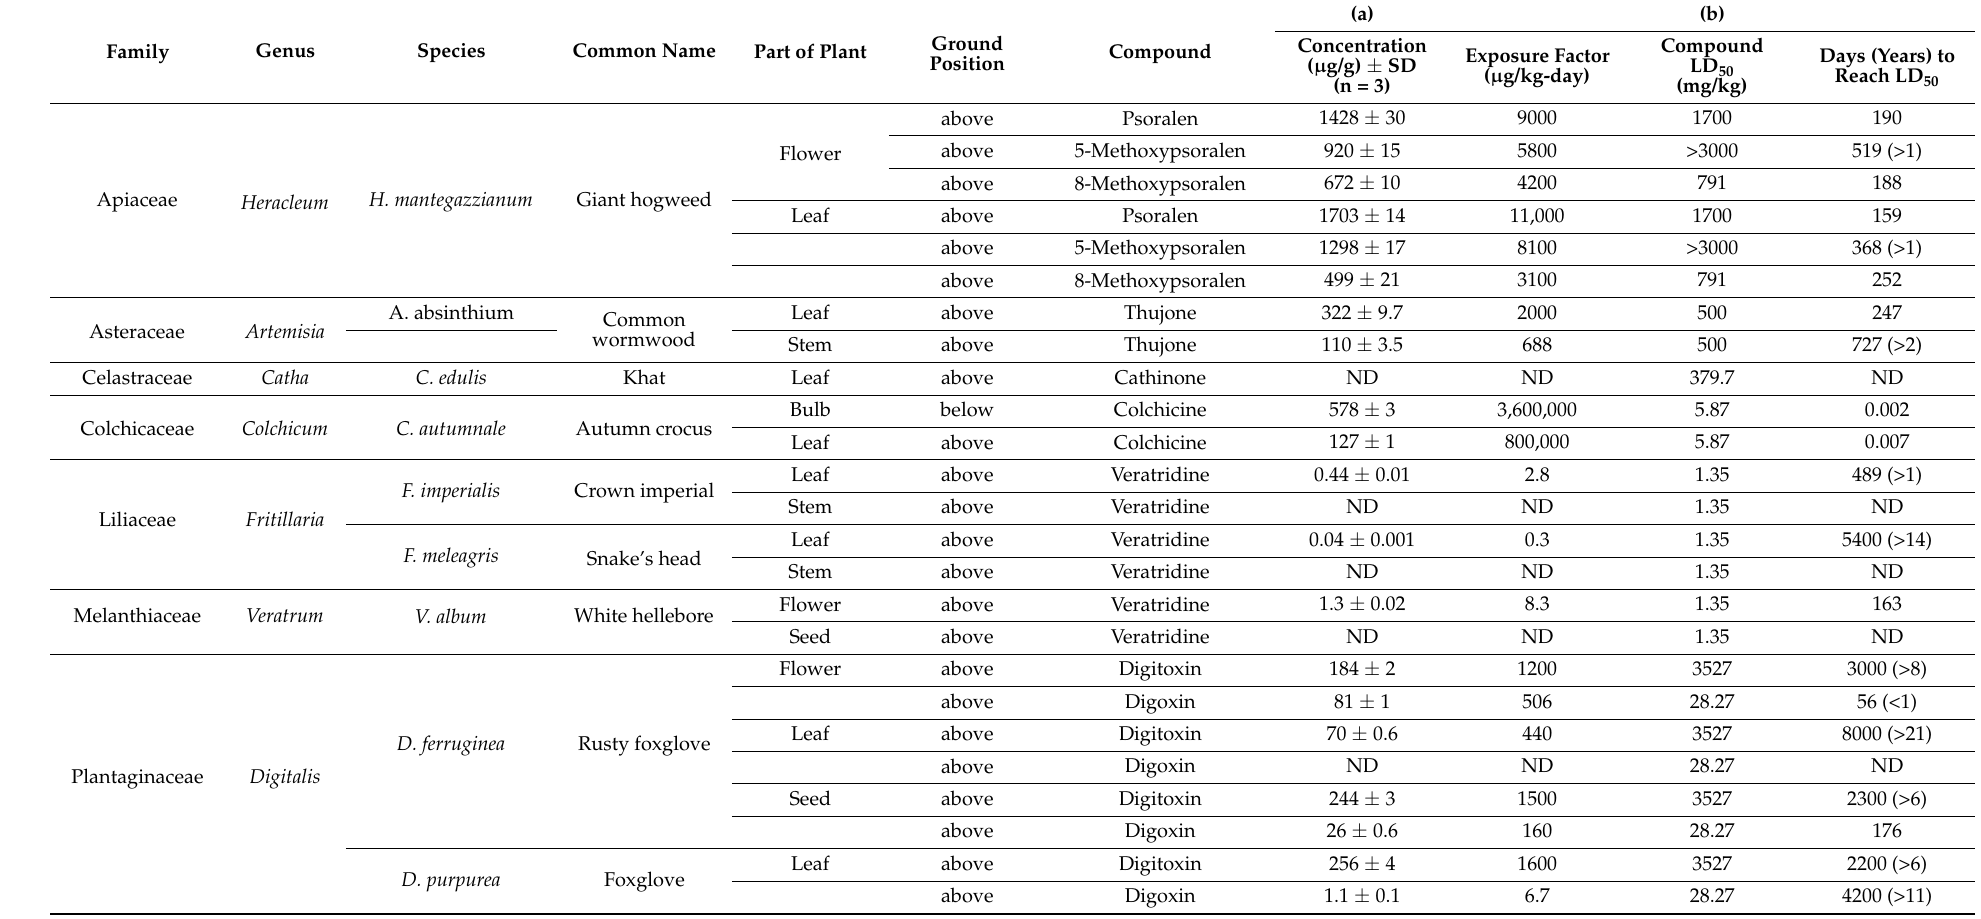
Table 5. Summary of plant toxin data (a) actual concentration, and (b) calculated human health